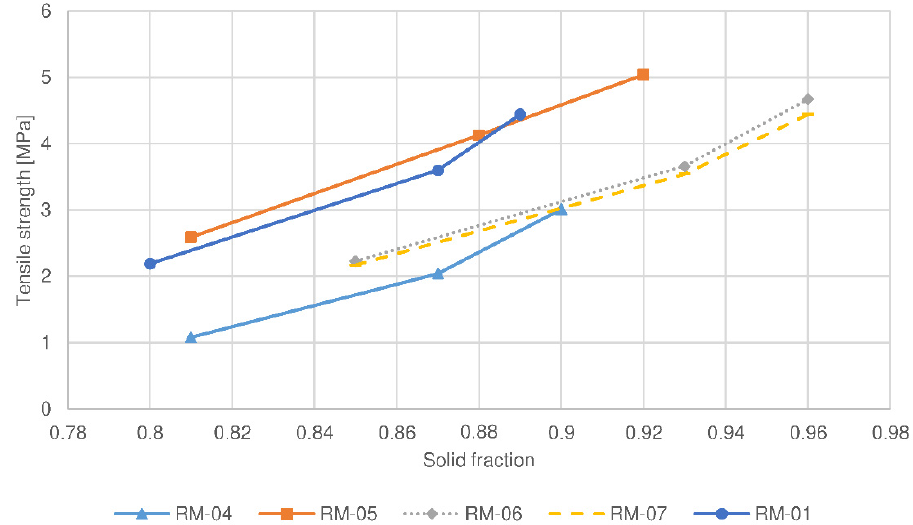
Figure 6. Compactibility plot of selected compression mixtures containing microcrystalline cellulose (MCC) as a filler.